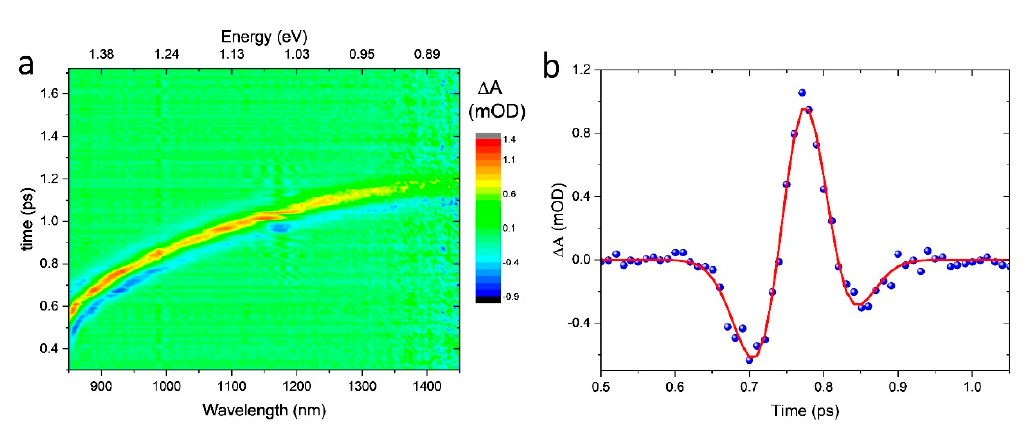
Figure 2. ( a ) Chirp of the supercontinuum probe measured by cross correlation with a pulse at 1150 nm in 0.2 mm fused silica substrate. Since the pump lies on the spectral region of the probe pulse, we employ a crossed polarization configuration with pump s-polarized and probe p-polarized. ( b ) Extracted time dependent kinetics at 940 nm probe wavelength (the blue circles are experimental data, the solid red line is the gaussian fit described in the text).